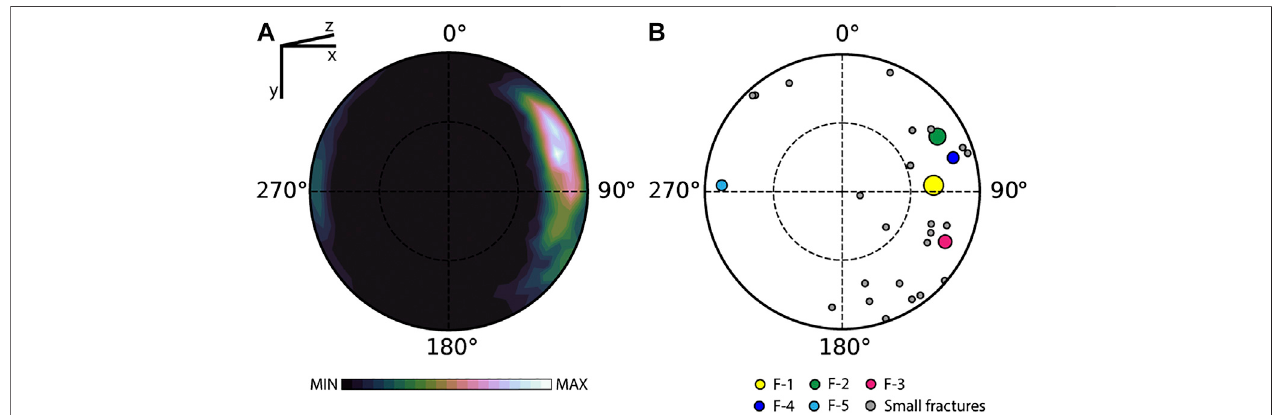
FIGURE 9 | Stereoplots of the poles to planes measured on the (A) FTPs and (B) separated fractures. The color and size of the poles in (B) re fl ect those of the fracture measured (cf., Figure 6 ).